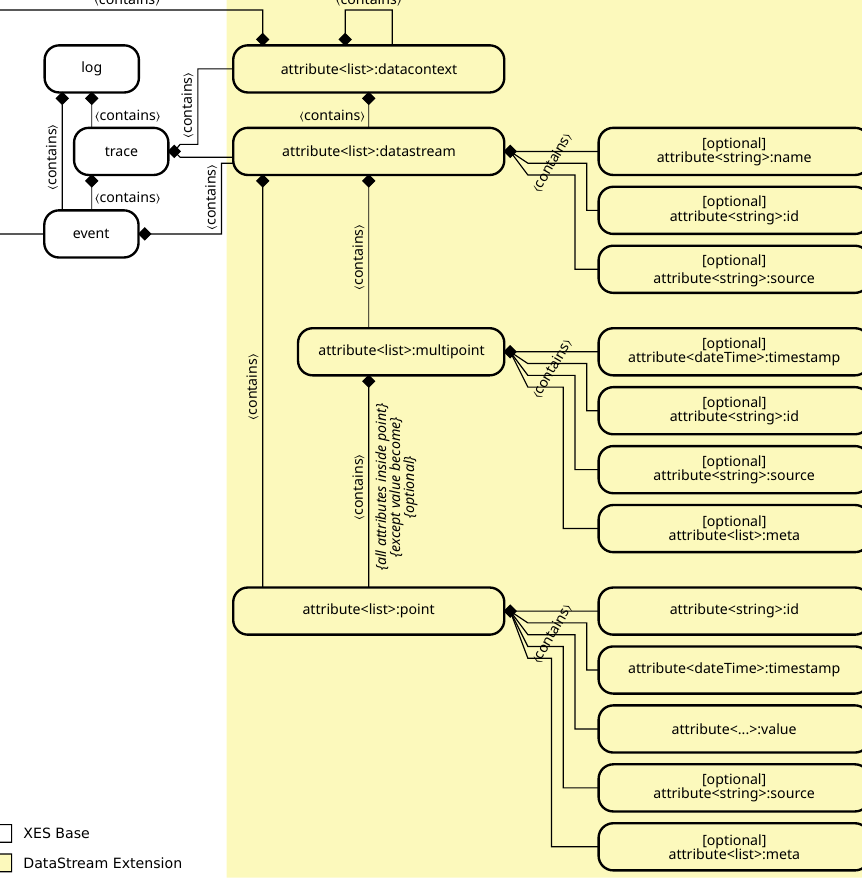
Figure 4. XES + DataStream Metamodel